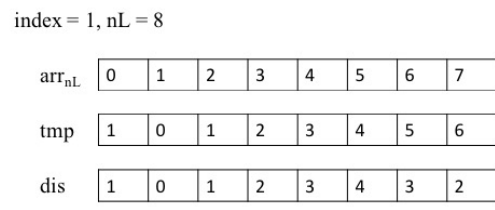
Figure 2. The illustration of index distance